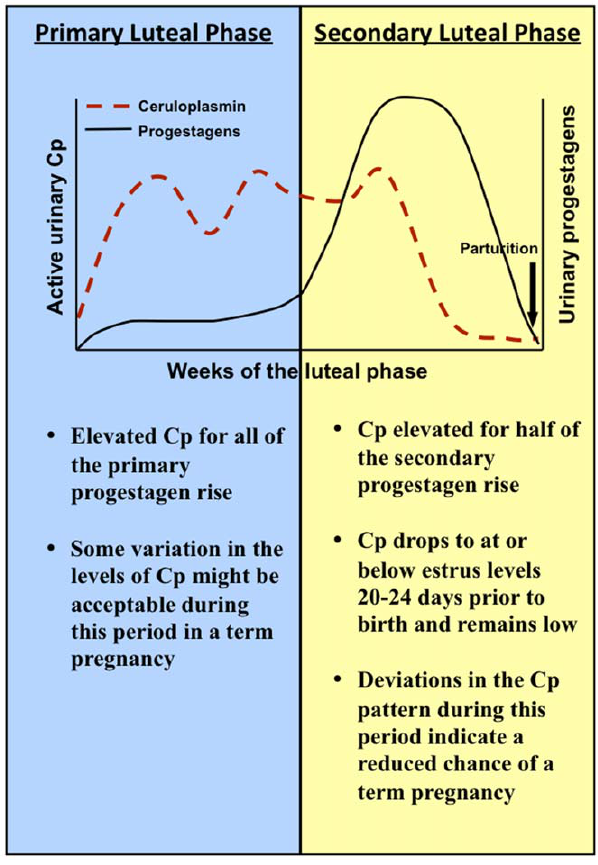
Figure 7. Schematic summary of elevated urinary ceruloplas- min and its relationship with progestagens during the pregnant luteal phase in the giant panda.